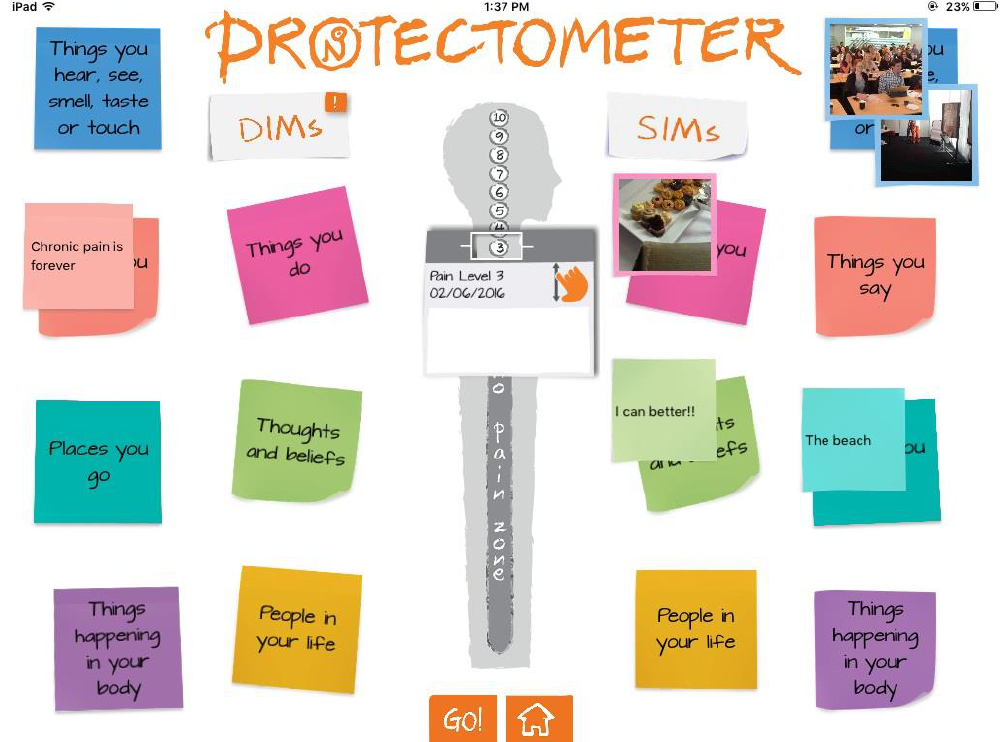
Figure 7. Example diagram of the ‘Protectometer’ tool provided in the available iOS app. Adapted from Protectometer: iOS Application in Appliquette . Available online